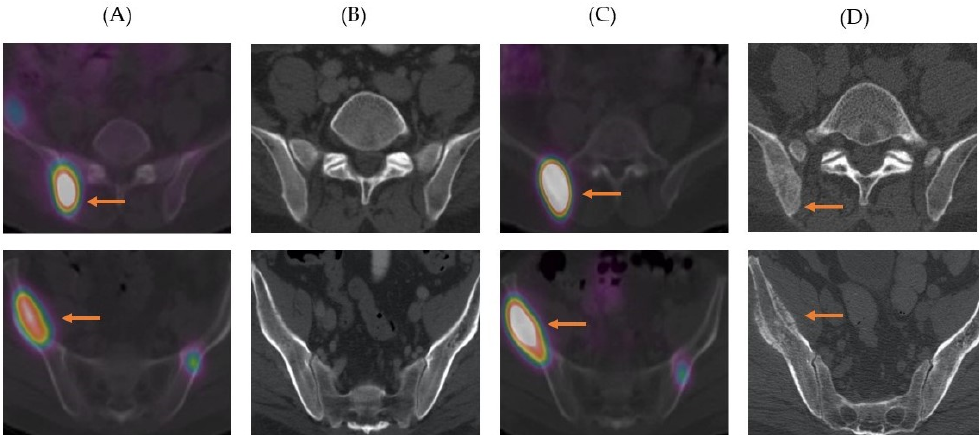
Figure 5. Primary pancreatic neuroendocrine tumor with metastases to liver, lymph nodes and bones. ( A ). Selected axial 177 Lu-DOTATATE SPECT/CT image post first cycle of therapy shows multi-focal uptake in iliac bones. ( B ). Selected axial CT image before therapy shows no corresponding osseous lesion. ( C ). Selected axial 177 Lu-DOTATATE SPECT/CT post fourth cycle of therapy shows persistent uptake at the similar locations. ( D ). Selected axial CT image after fourth cycle of therapy demonstrates sclerotic changes in the right iliac bone posteriorly and pathologic fracture and underlying sclerotic changes in the wing of right iliac bone.